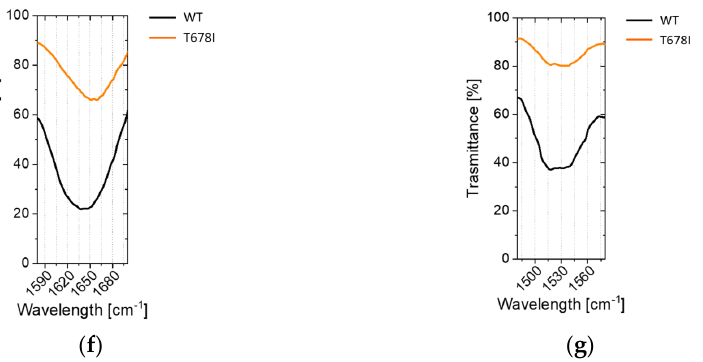
Figure 9 . ATR ‐ FTIR spectra of the SARS ‐ CoV ‐ 2 S ‐ derived peptides described in Table 1 ( a ) 400–4000 cm − 1 ; ( b , d , f ) 1580–1690 cm − 1 ; ( c , e , g )1480–1580 cm − 1 . ( b , c ) show His mutants vs. WT spectra; ( d , e ) show mutations at 681 vs. WT spectra; ( f , g ) show T678I vs. WT spectra.